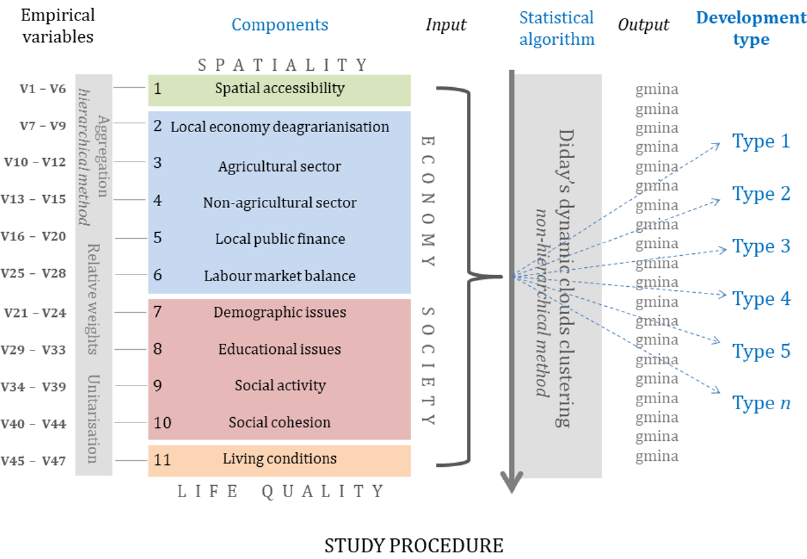
Figure 1. Diagram of the study procedure. Source: own